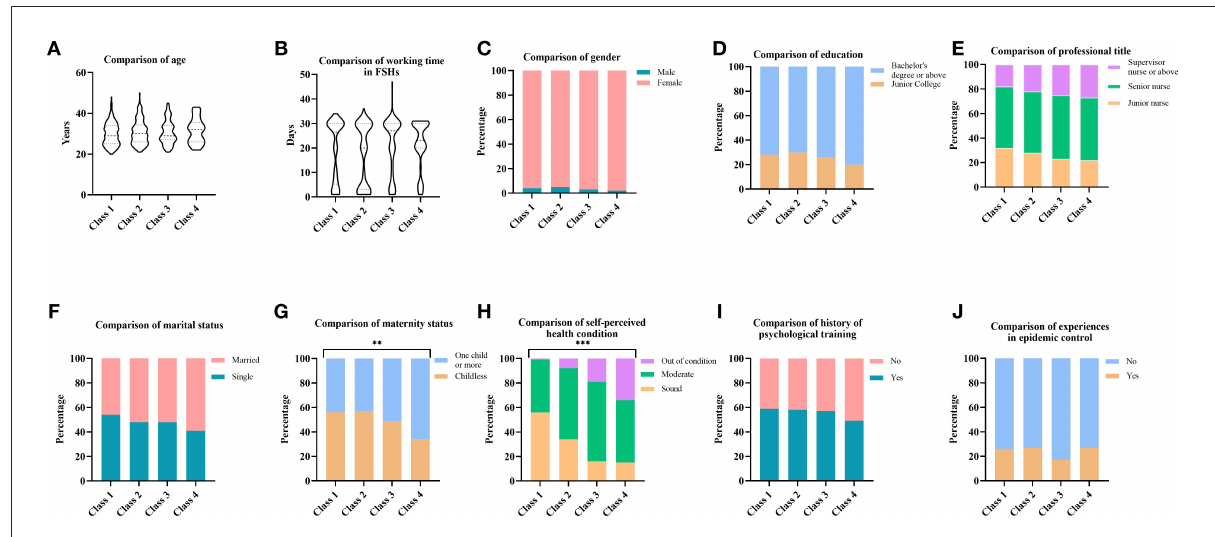
FIGURE2 (A–J) Characteristics of individuals in potential stress load classes. *** p < 0.001, ** p < 0.01.